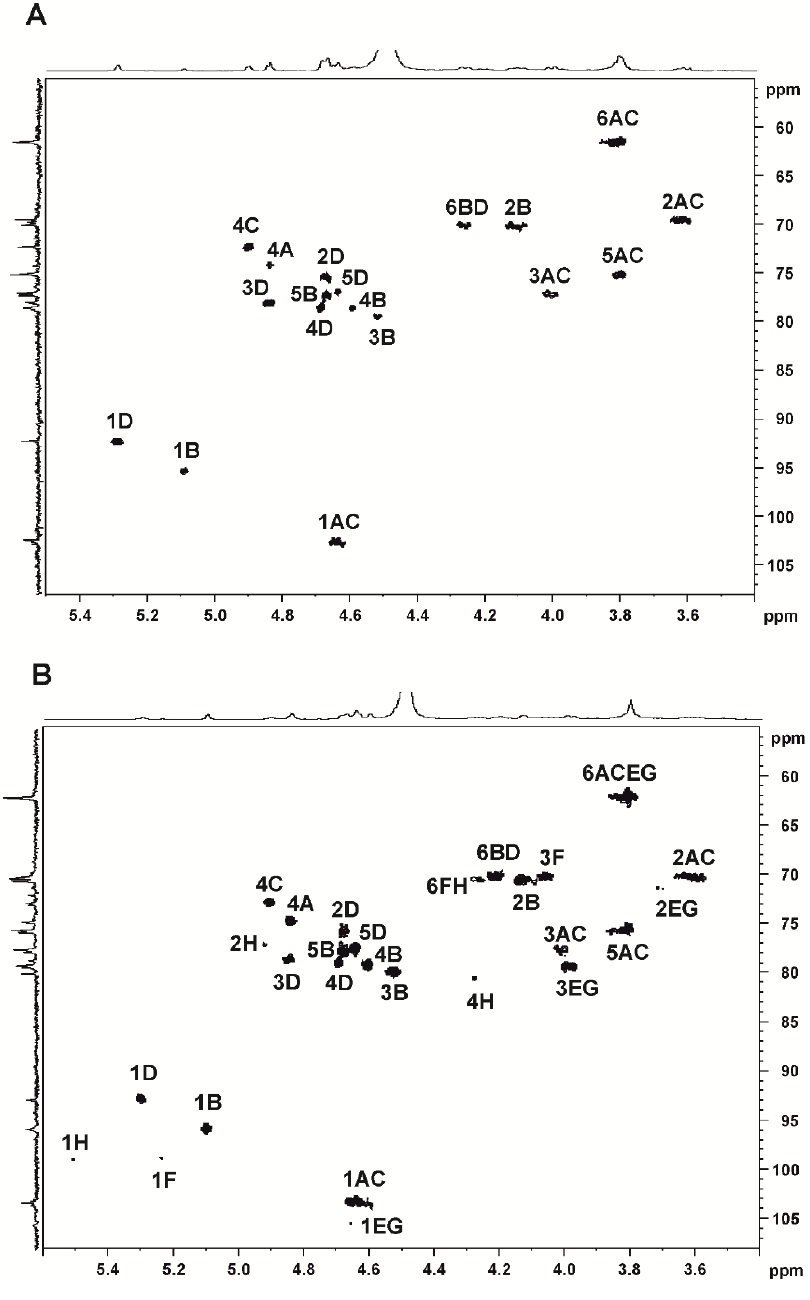
Figure 1. 13 C- 1 H HSQC NMR spectra of Afg-OS ( A ) and Mp-OS ( B ).